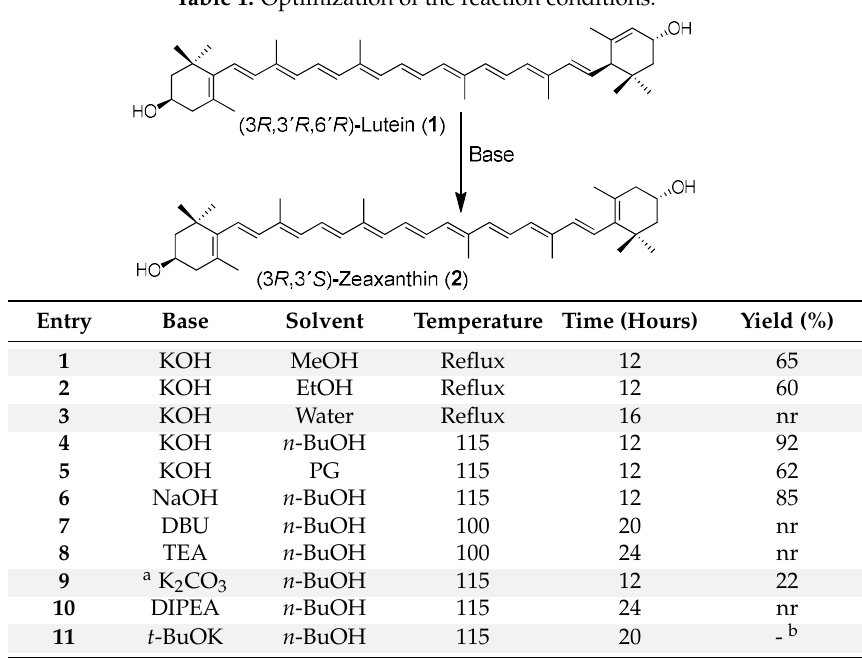
Table 1. Optimization of the reaction conditions.